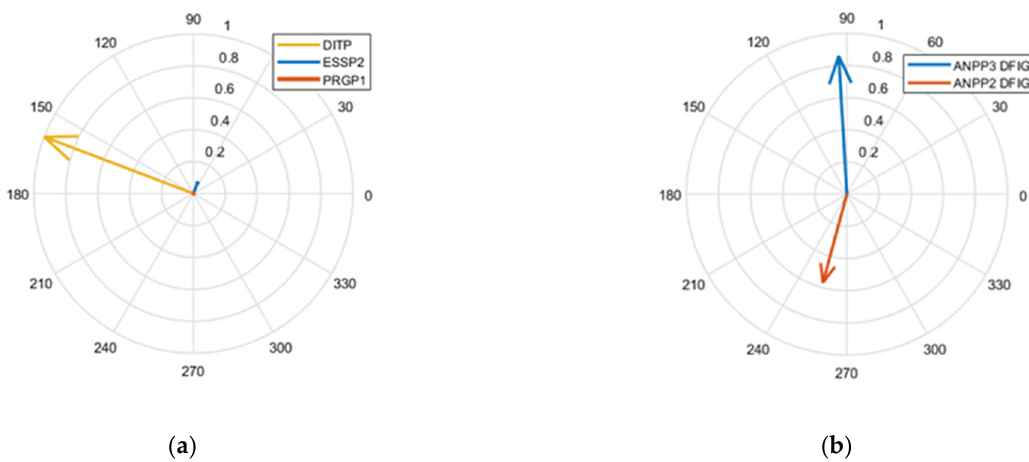
Figure 14. High Import DP: ( a ) oscillation vector of mode M5; ( b ) oscillation vector of mode D1.